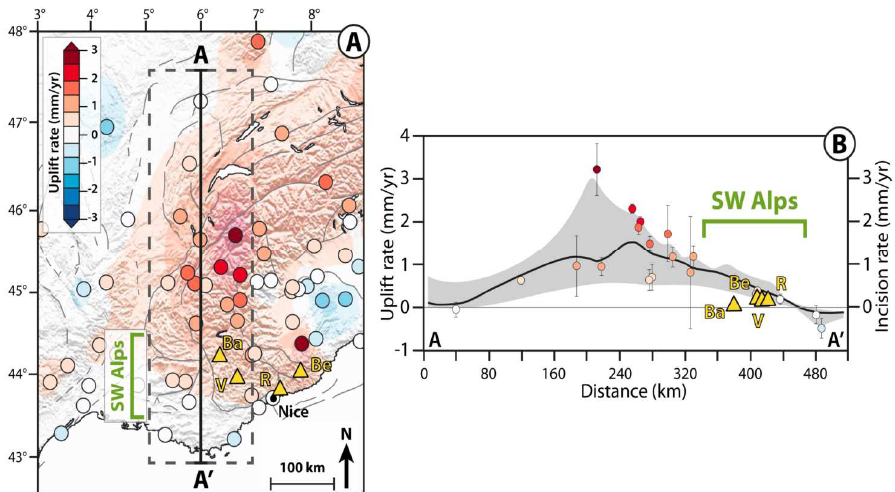
Figure 7. Long–term incision pattern of rivers of the SW Alps, out of the zone affected by glacial influence, constrained by CRE dating (data from [98–104]). ( A ), Vertical velocity field (colored circles) map of the Western Alps made by [77], with the location of gorges dated with 36 Cl cosmonuclide dating (yellow triangles): Ba, Barles [103]; V, Verdon, R, Rédébraus, Be, Bendola (Cardinal et al., in review). Positive (red) and negative (blue) values represent surface uplift or subsidence, respectively. ( B ) Vertical uplift estimated by GPS [77] and incision rates estimated from 36 Cl cosmonuclide dating versus distance. The black curve shows the median value of the vertical uplift rate, whereas the grey envelope shows the minimum and maximum vertical uplift rate values in the swath. Estimated incision rates have similar mean values to that of GPS rates, in the SW Alps.